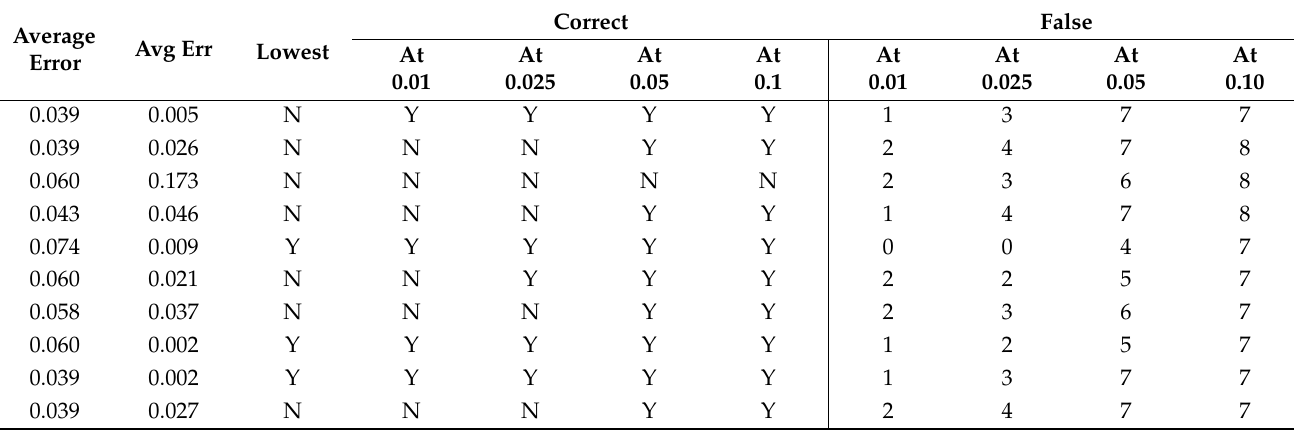
Table A93. Set 2, trials 1–10 summary data (all 0.5 PR